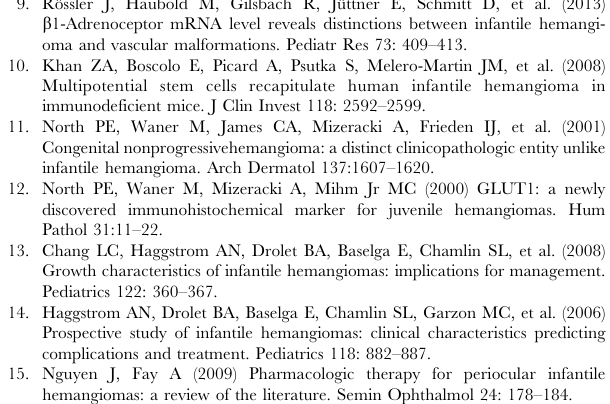
Table S1 Clinical characteristics of the samples under